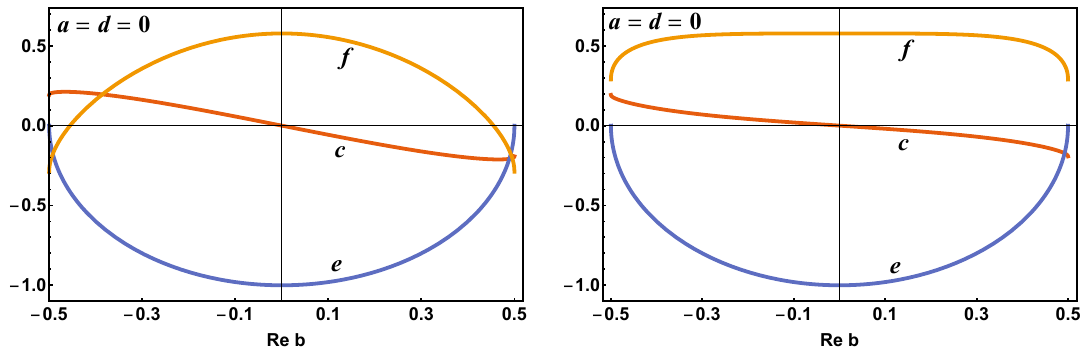
Figure 3 . The superpotential couplings, c; e , and f as functions of b that correspond to the Starobinsky solutions in (4.8).